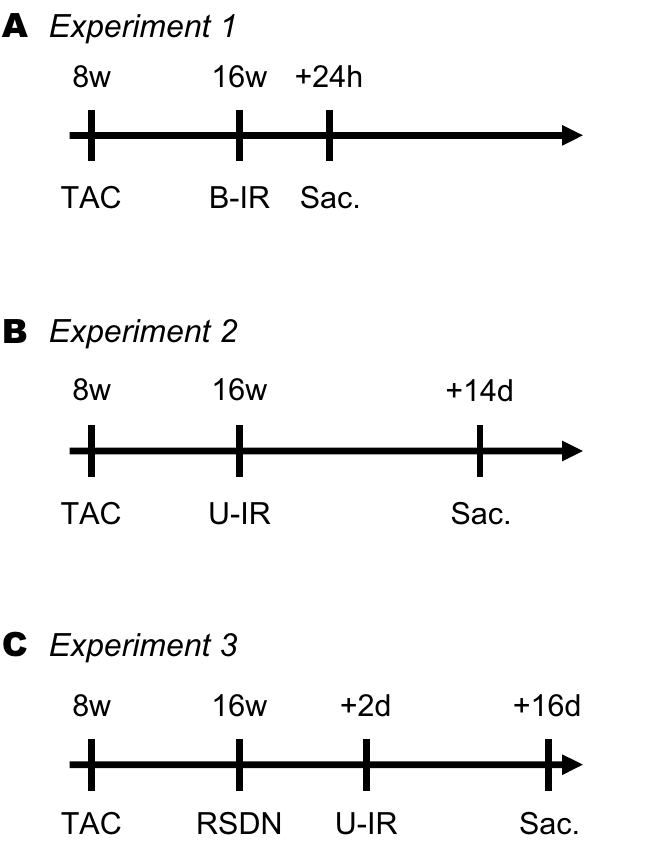
Figure 1. Experimental